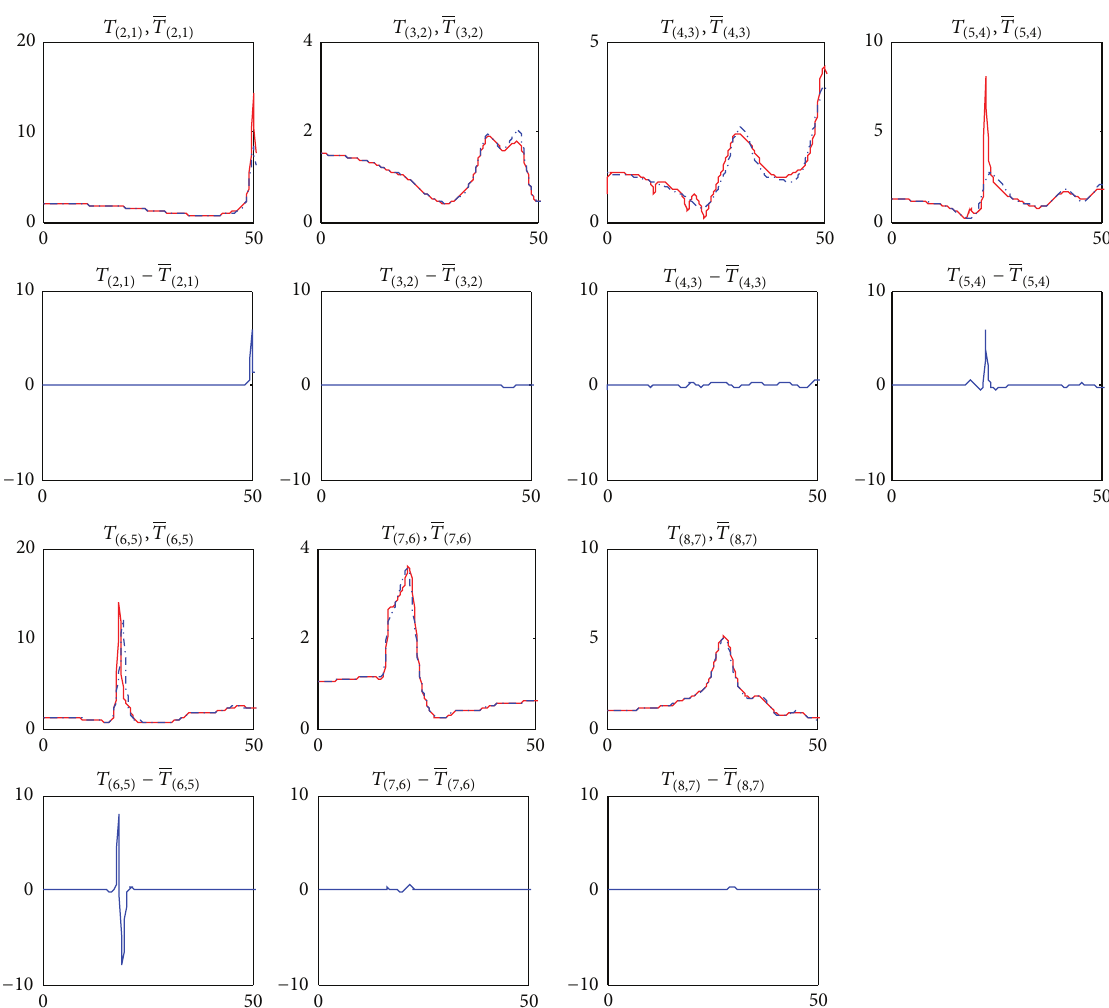
Figure 6: TFs of the system with nonlinear component before and after the variation and their difference versus frequency (Hz): blue— 𝑇 (𝑖+ 1 ,𝑖) , red— 𝑇 (𝑖+ 1 ,𝑖) .